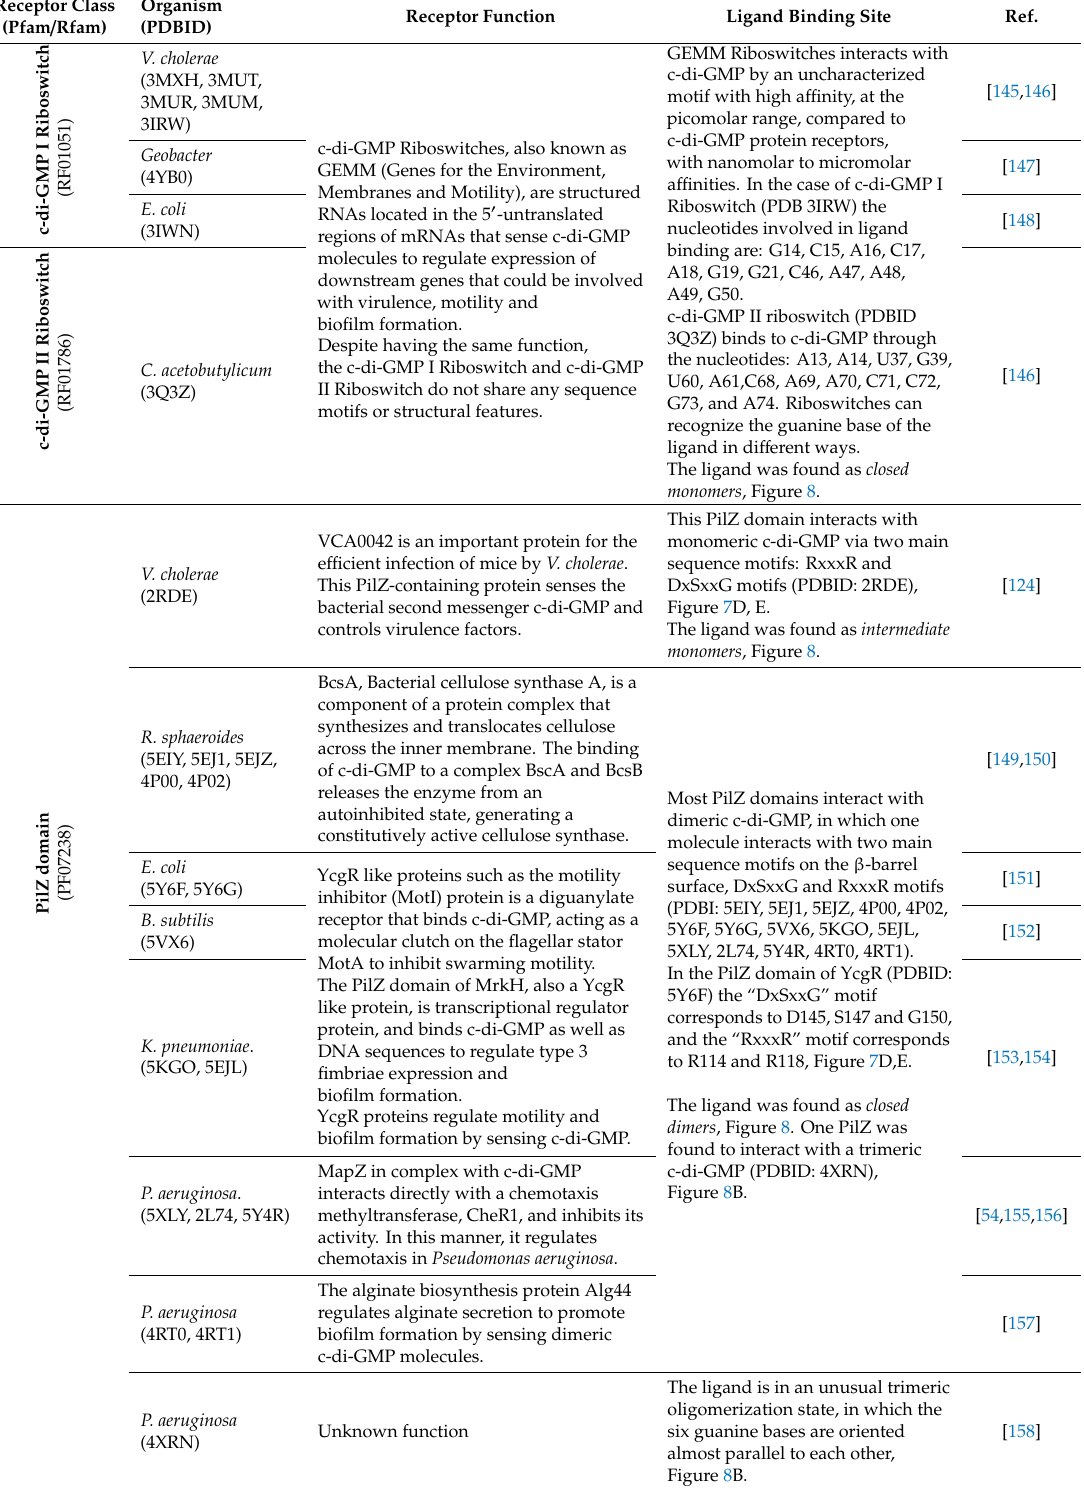
monomers , Figure